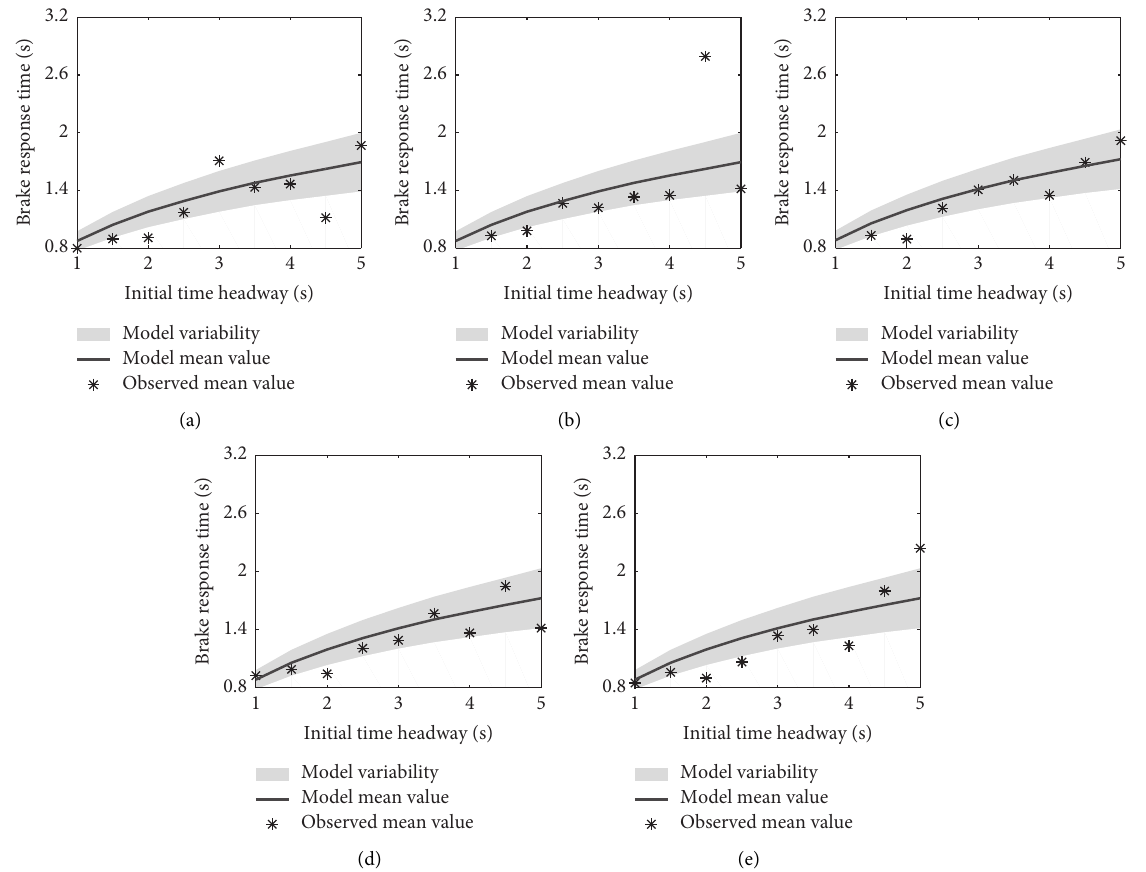
Figure 10: Simulation results versus observations obtained from simulator experiments, using τ − 1 . (a) No phone. (b) Hands-free (simple). (c) Handheld (simple). (d) Hands-free (complex). (e) Handheld